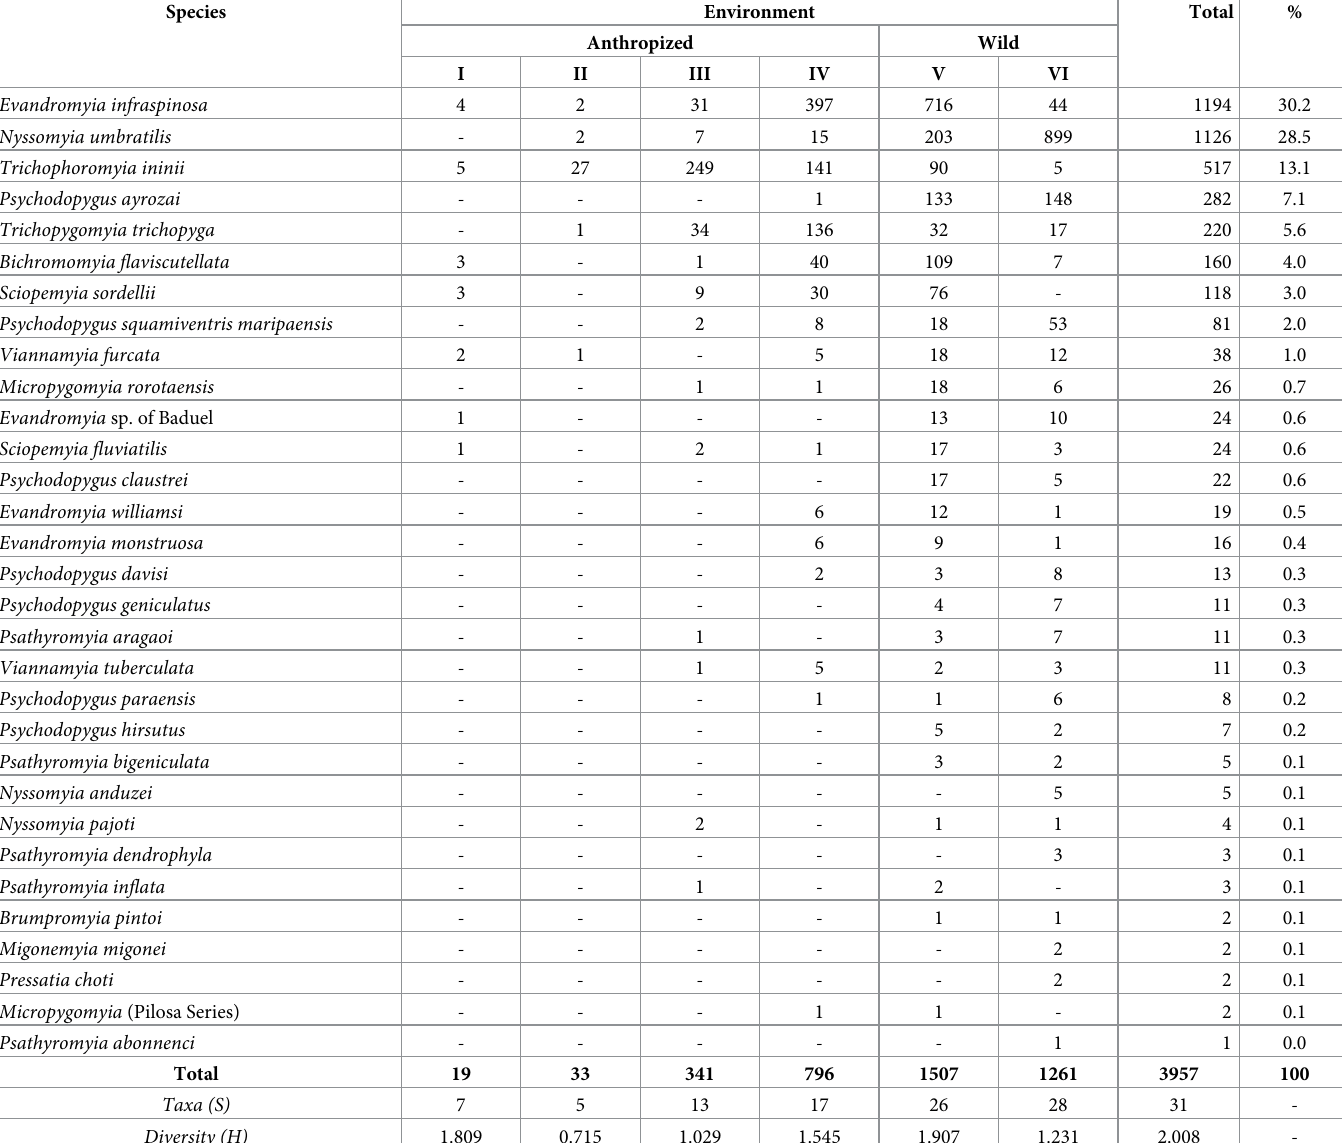
Table 1. Phlebotomine species composition and vertical/horizontal stratification in anthropized and wild environments of Oiapoque, Amapa´, Brazil, bordering French Guiana.